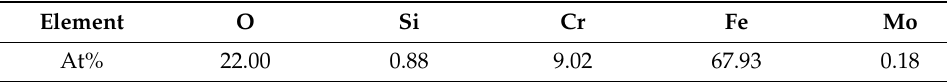
Table 5. EDS results of lamellar debris in the substrate (at%).